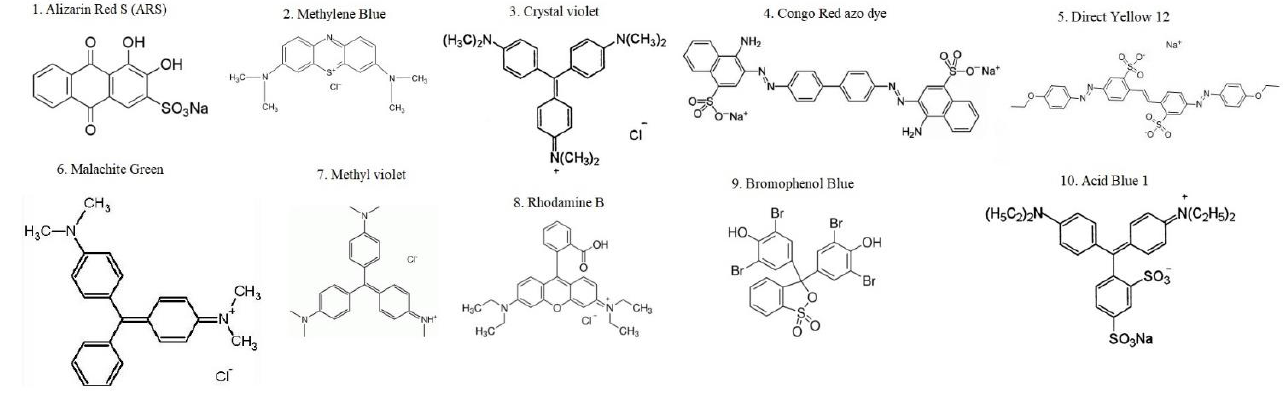
Figure 8. Chemical structures of dyes in textile wastewater.